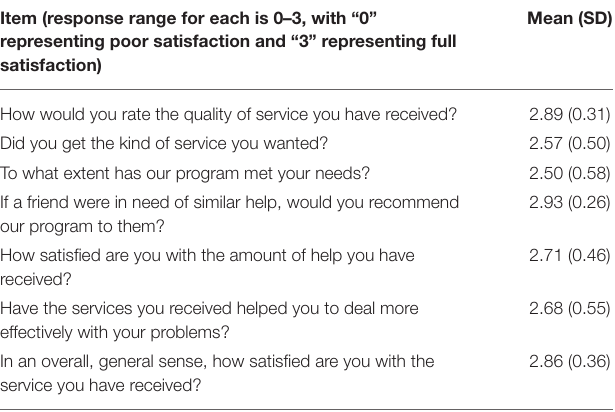
TABLE 3 | Participant satisfaction ( N = 28).